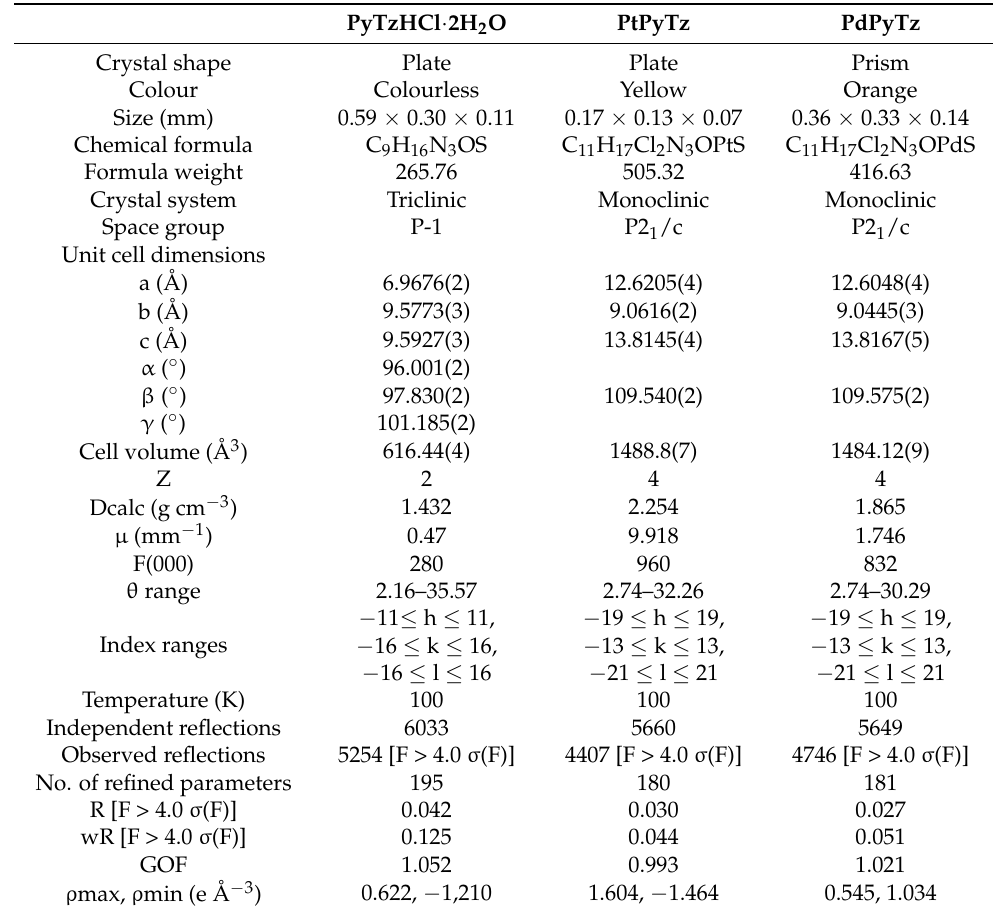
Table 4. Crystal data, data collection and refinement details for PyTzHCl · 2H 2 O, PtPyTz and